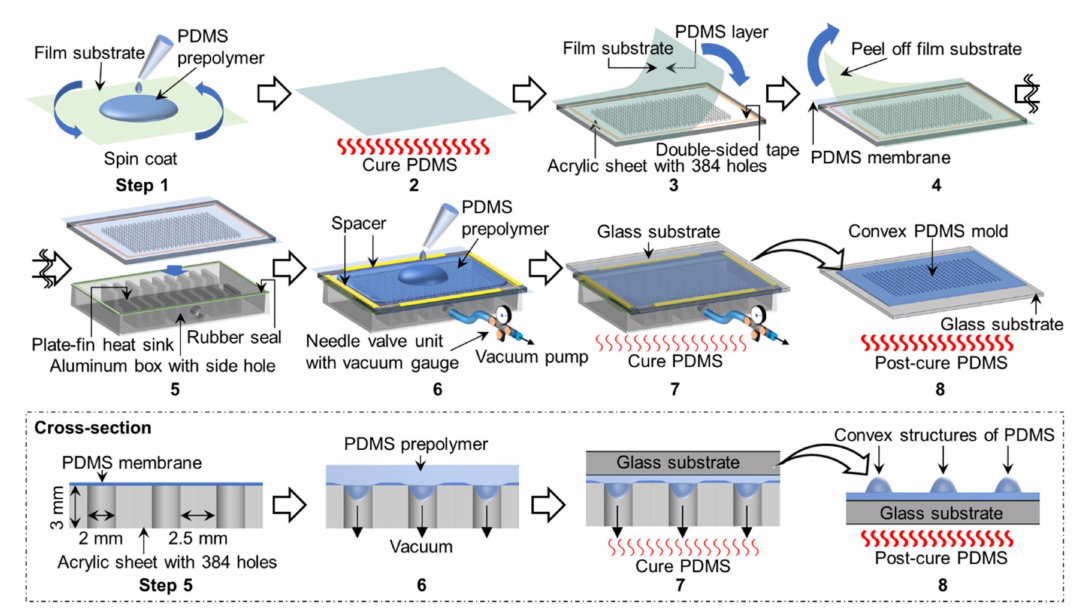
Figure 2. Schematic of the fabrication steps for convex PDMS mold. Steps 1,2: Preparation of a PDMS membrane on a film substrate. Steps 3,4: The PDMS membrane was adhered onto an acrylic sheet with 384 holes. Step 5: The acrylic sheet with the PDMS membrane was assembled onto an aluminum box with a side hole. Steps 6,7: PDMS prepolymer was poured and cured on the concaved PDMS membrane. Step 8: Post-curing the PDMS